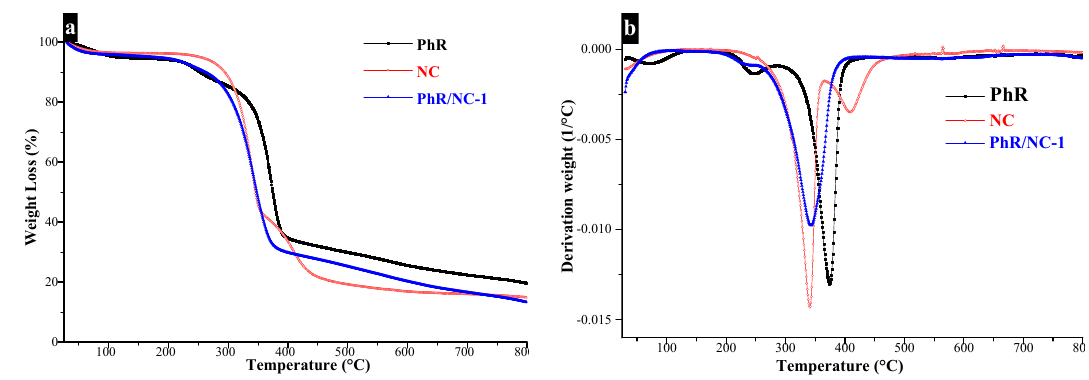
Figure 5. ( a ) Thermo gravimetric analysis of individual precursors (PhR and NC [43]) and the composite PhR/NC-1; ( b ) their corresponding derivative weight loss curves.